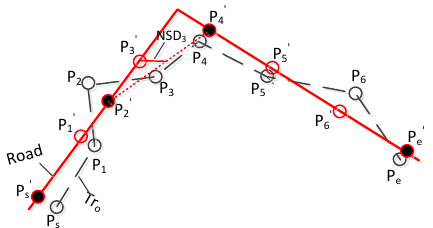
Figure 4. Network homomorphic distance